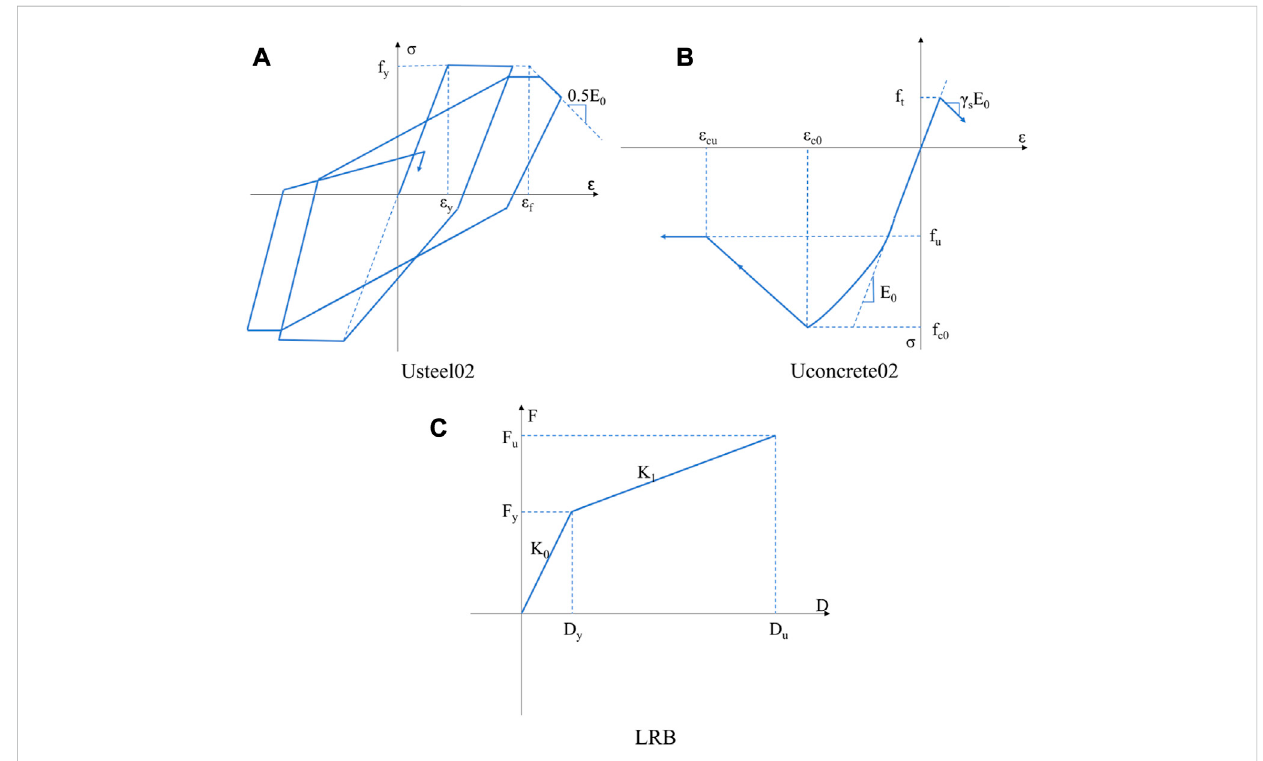
FIGURE 2 Structural non-linear constitutive relationships.